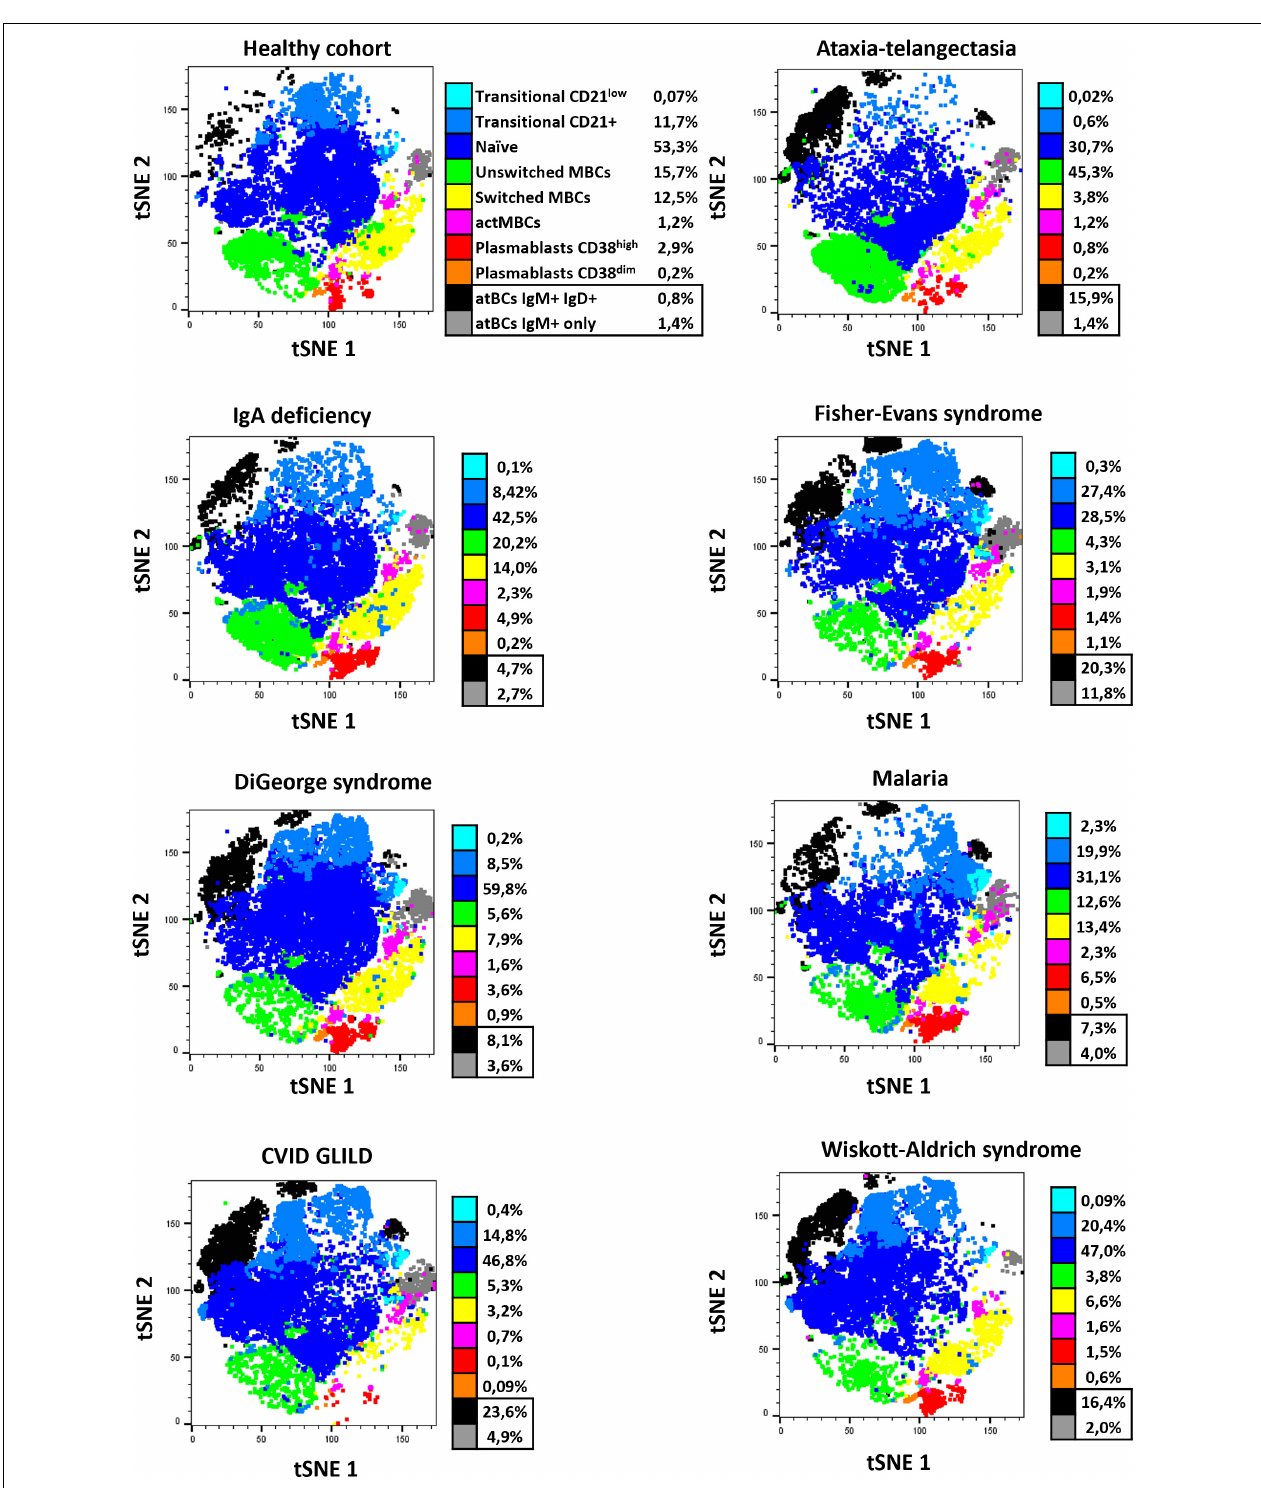
FIGURE 5 | tSNE B-cell subset characterization of representative healthy pediatric individuals and study patients. Seven observed diseases in patients with atBCs increase [ataxia-telangiectasia, n = 2; IgA deficiency, n = 2; Fisher-Evans syndrome, n = 2; DiGeorge syndrome, n = 2; Malaria, n = 2; CVID granulomatous-lymphocytic interstitial lung disease (GLILD), n = 3; Wiskott-Aldrich syndrome, n = 2] and healthy controls ( n = 3) were selected for a reduced dimensionality analysis, by using merged t-stochastic neighbor embedding (tSNE). Flow cytometric Self-Organizing Map (FlowSOM) was used to automatically identify B-cell subsets in each